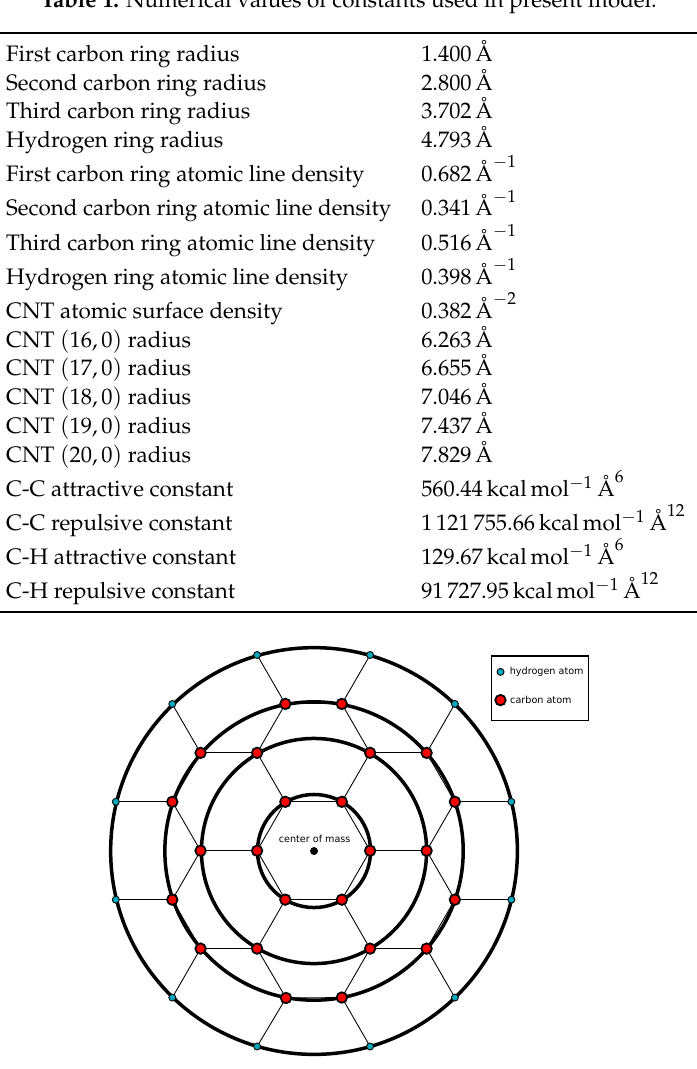
Figure 1. Model of coronene molecule with inner carbon rings and outer hydrogren